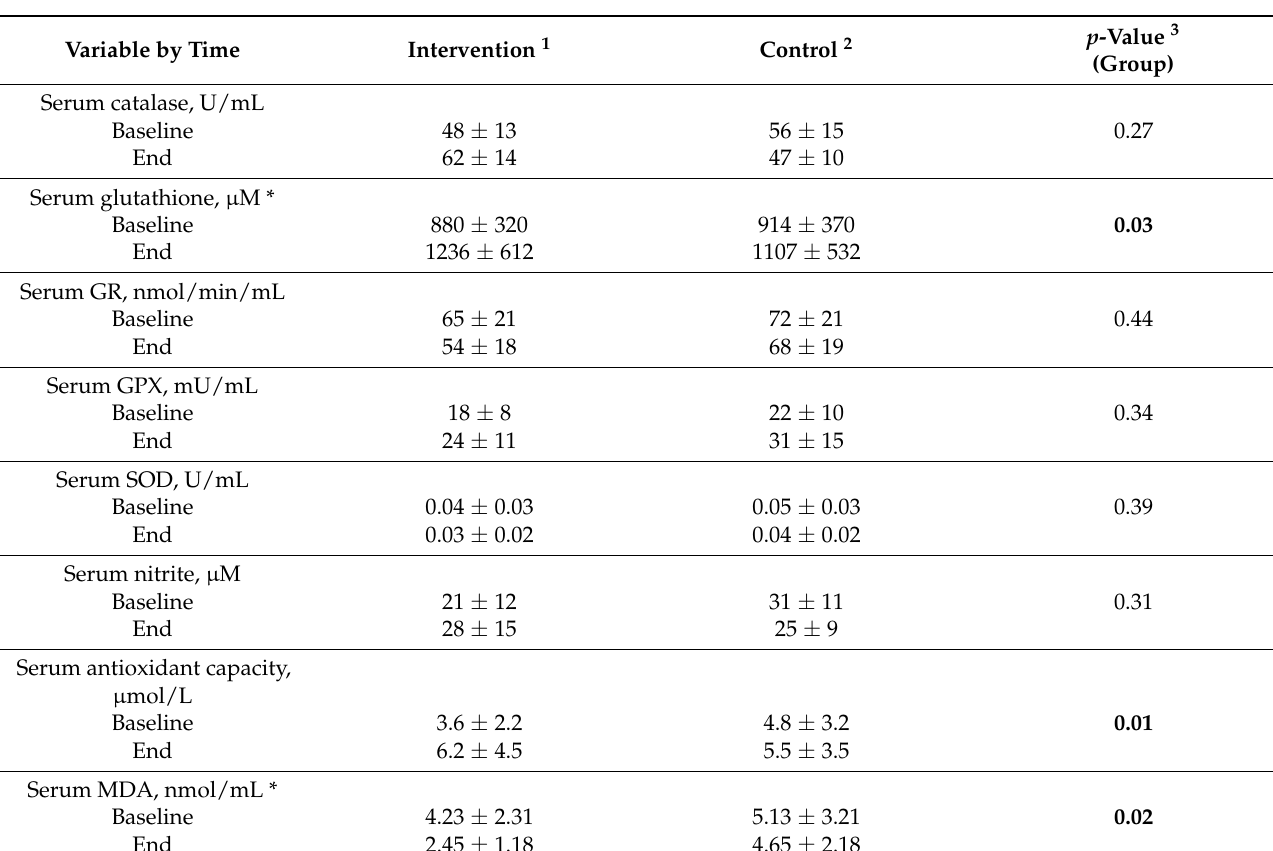
Table 1. Serum antioxidants and oxidative stress biomarkers in women with obesity and at risk for gestational diabetes in dietary intervention vs. control group for a period of 18 gestation